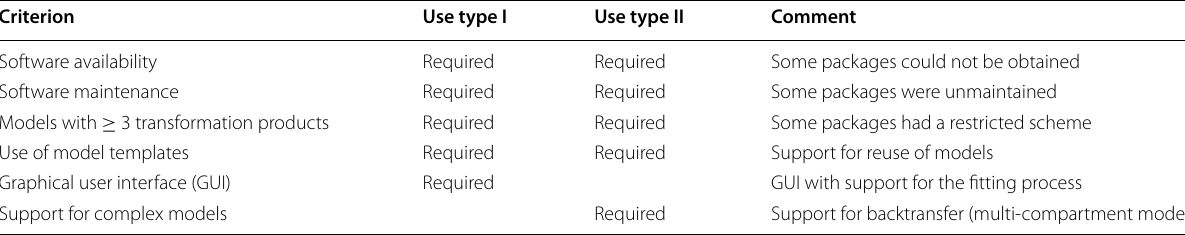
Table 1 Relevant exclusion criteria used for screening the software packages